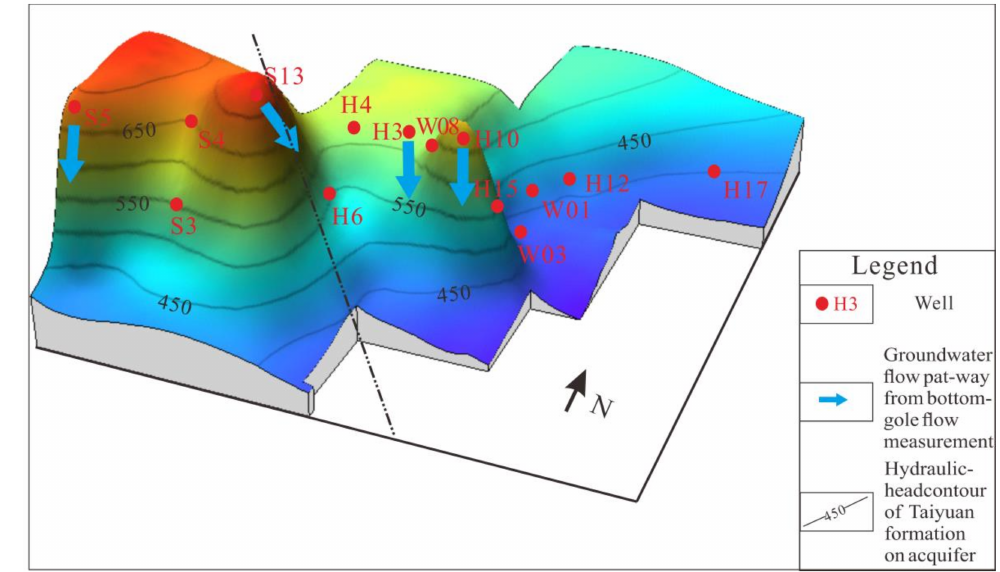
Figure 9. Hydraulic head contour of Taiyuan Formation